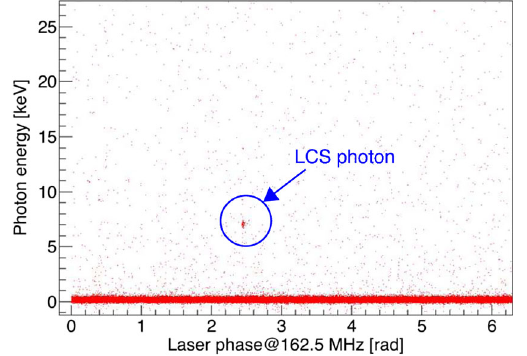
FIG. 23. Detected energy versus phase difference between the cERL rf and laser.